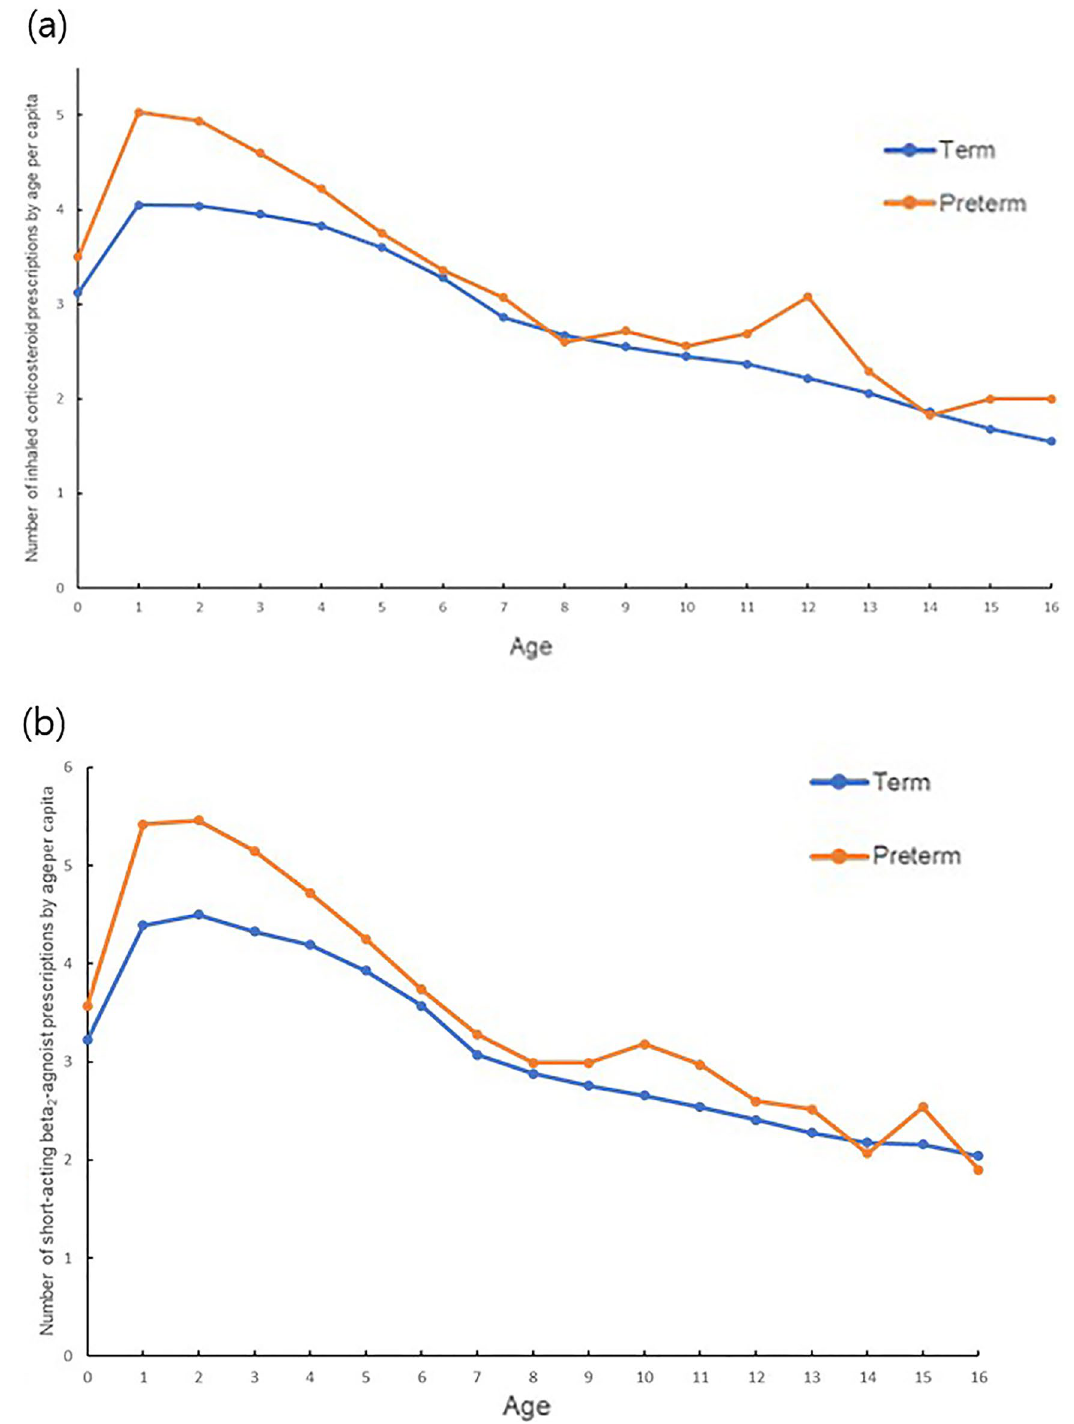
Figure 2. ( a) Number of inhaled corticosteroid prescriptions per asthma patient for term and preterm infants by age per capita. ( b) Number of prescriptions for short-acting β2 agonists per asthma patient for term and preterm infants stratified by age per capita. The number of inhaled medications prescribed to asthmatic patients are expressed by the orange and blue lines for preterm and term infants,